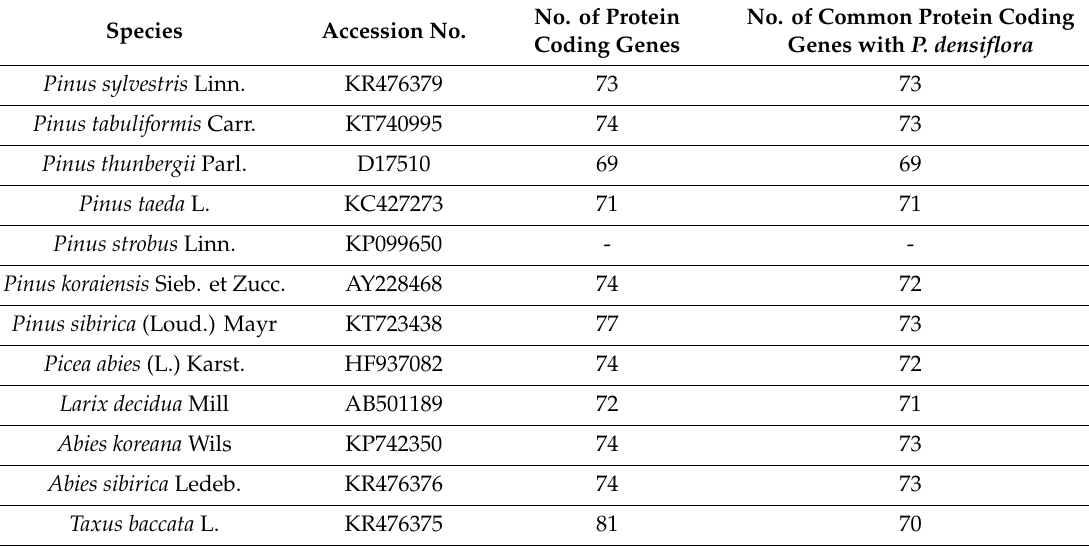
Figure 4. Phylogenetic tree based on protein coding genes (CDSs) of P. densiflora and 12 reference species. Bootstrap values (%) are shown above branches. Table 4. Chloroplast genome comparison with 12 conifer species.